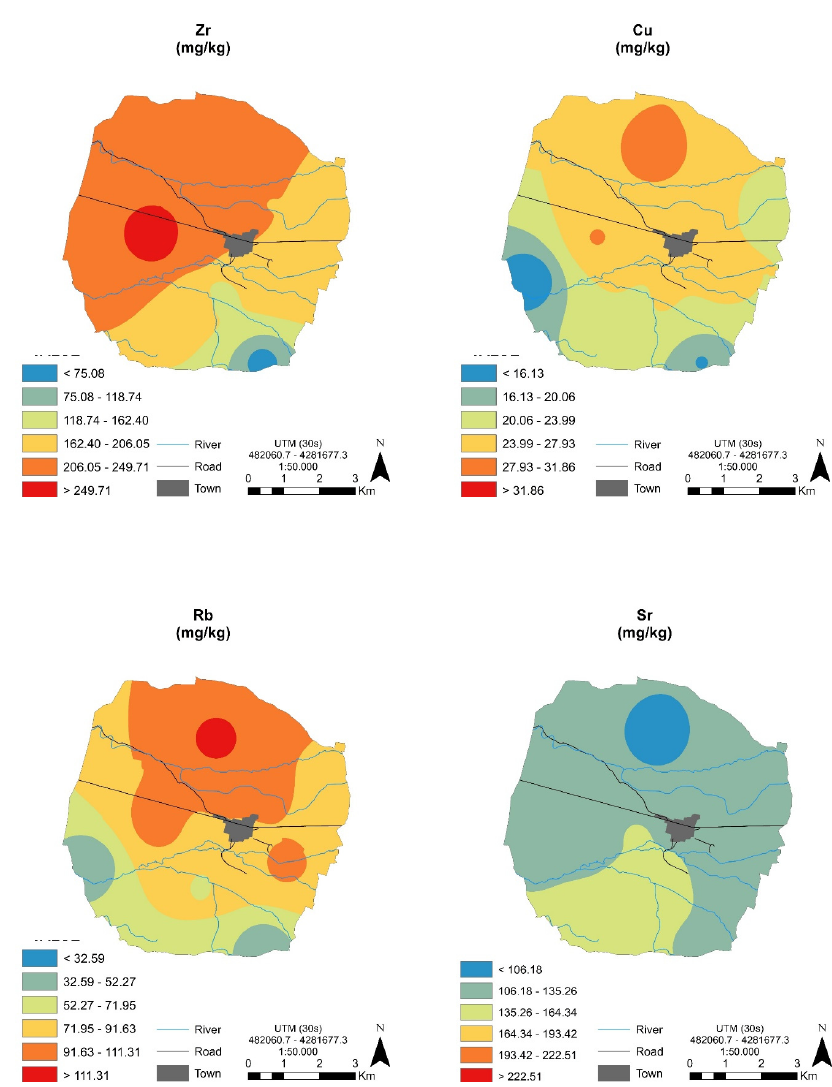
Figure 4. Geo-spatial prediction maps for some trace elements in subsurface soil